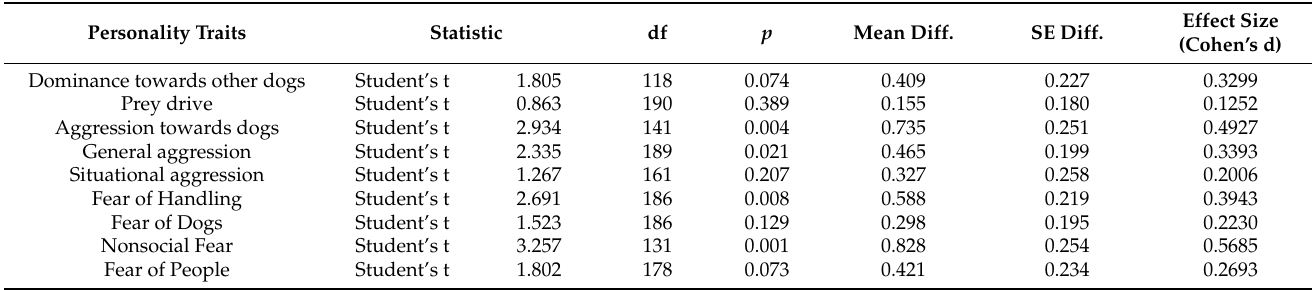
Table 4. Independent samples t -test on the facets that emerged from the construct validity analysis. Significance < p a 0.05; >0.10 indicates a statistical trend close to